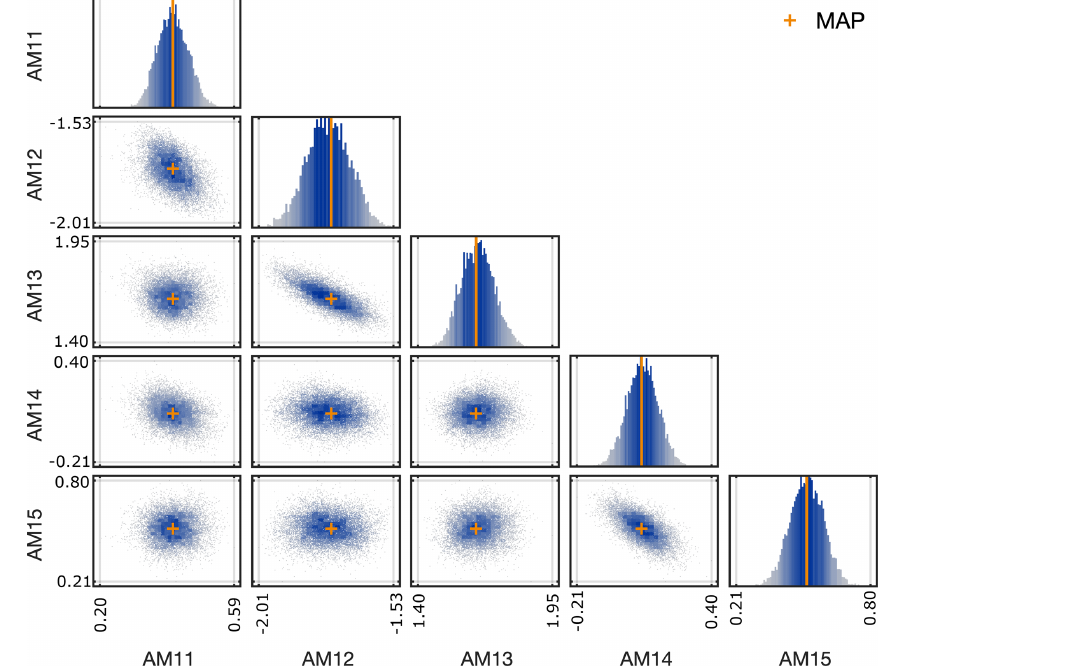
Figure 11. Samples of the posterior distribution of yaw model parameters for the New MEXICO test case. The orange crosses correspond to the MAP estimates.